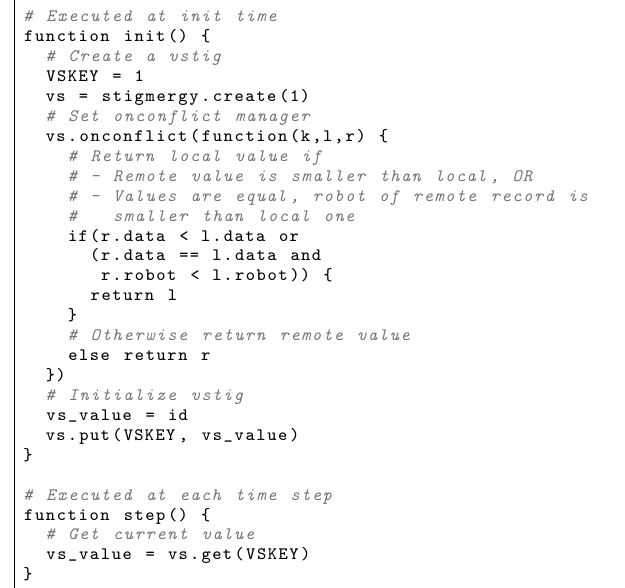
Figure 1: The Buzz code executed on the robots to test the performance of virtual